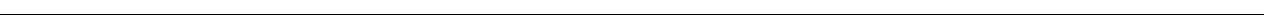
Figure 6 | Chd7 recruits Top2b to activate long neuronal genes. ( a ) Volcano plots depict gene expression changes ( P o 0.05) between CGNs treated with ICRF-193 or DMSO (left panel) and between WT [ Chd7 f/f ] and Chd7 homozygous mutant [ Atoh1-Cre::Chd7 f/f ] CGNs (right panel). Genes longer than 100kb are labelled as red dots. The grey lines show the position of fold change of 1.5. ( b ) Gene Set Enrichment Analysis (GSEA) of genes that were significantly downregulated ( P o 0.01) in CGNs upon ICRF-193 treatment in WTand Chd7 mutant CGNs (left panel) and were significantly downregulated in Chd7 mutant CGNs ( P o 0.01) in ICRF-193- and DMSO-treated WT CGNs (right panel). P o 0.001. NES: N ormalized E nrichment S core. ( c ) Heatmap of the expression of genes activated by both Chd7 and Top2b in WTand Chd7 mutant CGNs, and ICRF-193- or DMSO-treated CGNs and cells cultured with (GNPs) or without SAG (CGNs). The colour scale is shown on the right. ( d ) qRT–PCR analysis represented Top2b-activated genes in CGNs. The level of Gapdh transcripts was used for normalization. Bars represent normalized mean value ± s.d. from four samples for each group. P ¼ 0.0003; 0.001; 0.0035; 0.005; 0.0006; 1.0E-5 (from left to right). ( e ) qRT–PCR analysis of the represented genes in Chd7 WTand mutant CGNs. The level of Gapdh transcripts was used for normalization. Bars represent normalized mean value ± s.d. from four samples for each group. P ¼ 0.001; 1.8E-5; 0.0004; 0.028; 0.035; 0.0016 (from left to right). ( f ) ChIP-seq density heatmaps for Chd7 in GNPs and Top2b in CGNs within ± 2kb of the Chd7 peak centre. ( g ) ChIP-seq density heatmaps depict altered Top2b ChIP-seq peaks ( P o 0.01, fold change 4 2) between WT and Chd7 mutant CGNs. Regions within ± 2kb of the Top2b peak centre are shown. ( h ) Track view of ChIP-seq density profile for Chd7 in GNPs and Top2b in WTand Chd7 mutant CGNs in the region upstream of Cadps2 gene. ( i ) GSEA of selected genes that have at least one decreased Top2b ChIP-seq peak in Chd7 -deficient CGNs in ICRF-193- and DMSO-treated WT CGNs. P o